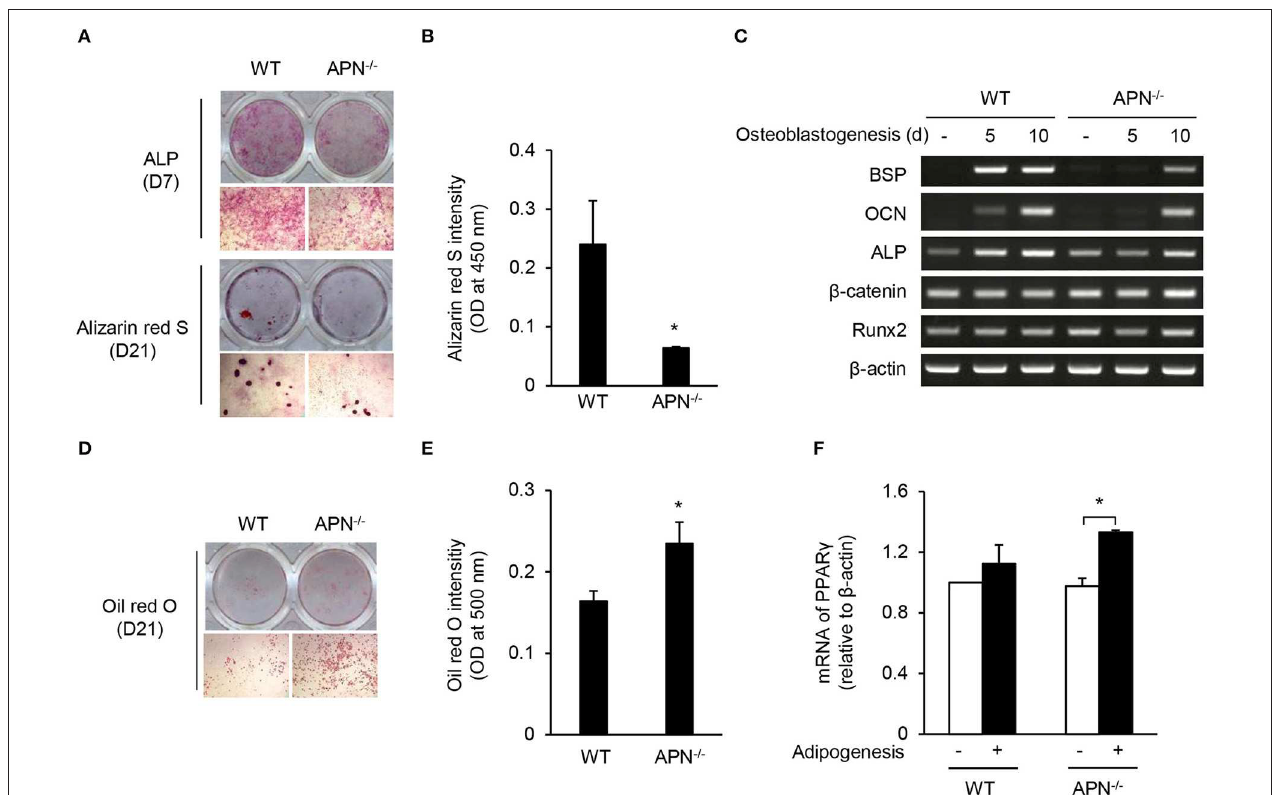
FIGURE 3 | Adiponectin-deficient calvarial cells preferentially differentiate into adipocytes. (A–C) Mouse calvarial cells were incubated with β -glycerophosphate (10mM) and ascorbic acid (50 µ M) to induce osteoblast differentiation. (A) The cells were stained for ALP at day 7 and with alizarin red S at day 21 (upper, whole-well image; lower, 40 × magnification). (B) Alizarin red S-stained cells were dissolved in 20% methanol and 10% acetic acid and the optical density (OD) was measured at 450nm. (C) At days 5 and 10, total RNAs were isolated, reverse-transcribed, and subjected to RT-PCR to determine the mRNA levels of BSP, OCN, ALP, β -catenin, Runx2, and β -actin. (D–F) Mouse calvarial cells were incubated with dexamethasone (1 µ M), insulin (5 µ g/ml), and IBMX (0.5mM) for the evaluation of adipogenic potential. (D) At day 21, the cells were fixed and stained using oil red O (upper, whole-well image; lower, 40 × magnification). (E) The oil red O-stained cells were dissolved in isopropanol and the OD was measured at 500nm. (F) At day 5, total RNAs were isolated, reverse-transcribed, and subjected to RT-PCR. The ratio of PPAR γ to β -actin was obtained by using a densitometer. Data are mean values ± SD of triplicate samples and are representative of three similar independent experiments. * P <